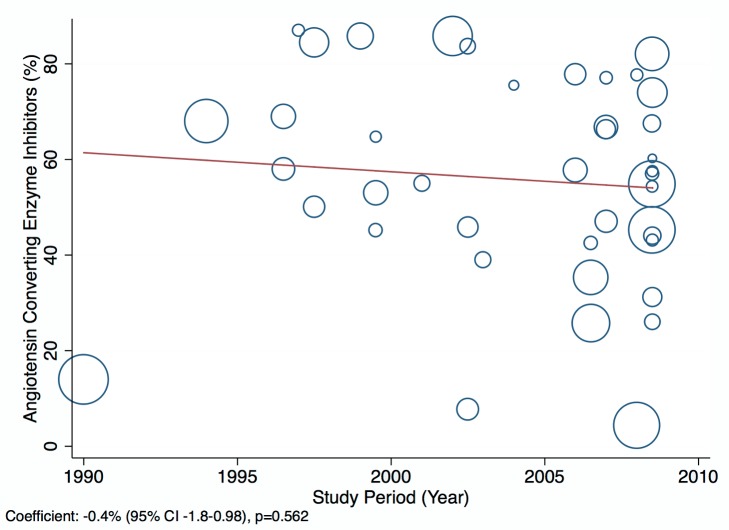
Meta-regression of angiotensin-converting enzyme inhibitor use against study period.